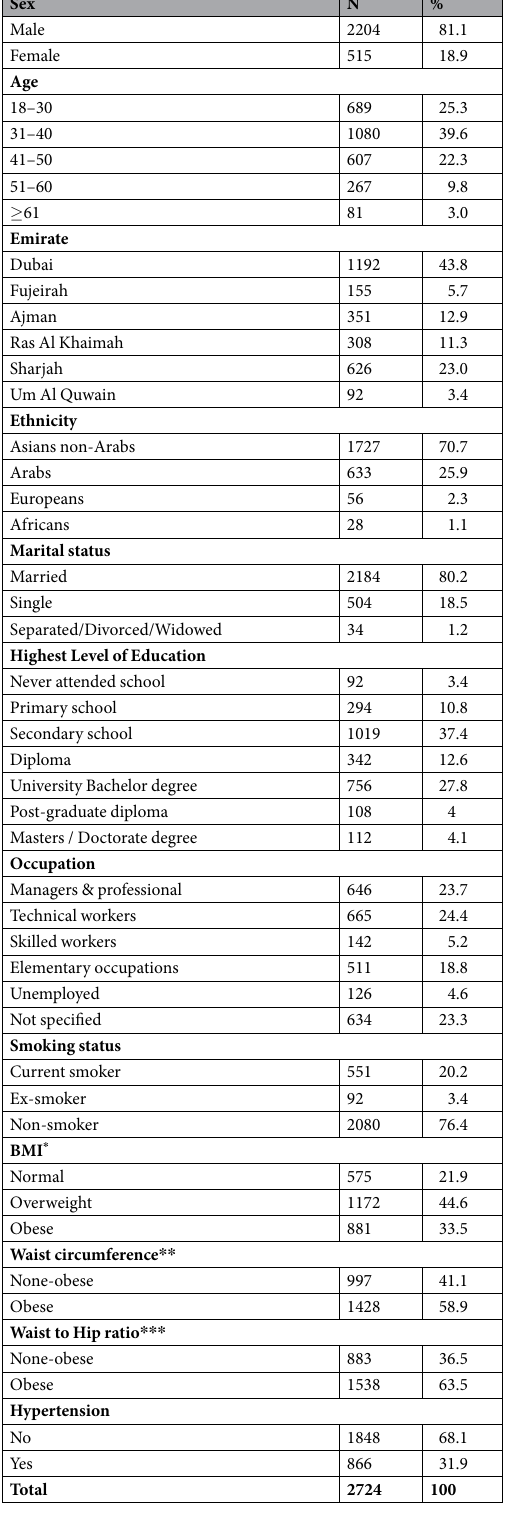
Table 1. Demographic Characteristics of Migrant Study Population. * BMI was categorized according to the following criteria (Normal: Arabs & Europeans – BMI < 25 Asians–BMI < 23; Overweight:Arabs & Europeans – 25 ≤ BMI < 30, Asians – 23 ≤ BMI < 27.5; Obese: Arabs & Europeans – BMI ≥ 30, Asians – BMI ≥ 27.5). ** Waist Circumference was categorized according to the following criteria (obese: Arabs – males WC ≥ 102 cm & females ≥ 88; Asians – males WC ≥ 90 cm & females ≥ 80; Europeans – males WC ≥ 94 cm & females ≥ 80). *** Waist to Hip ratio (WHR) was categorized according to the following criteria (WHR for males ≥ 0.90 cm & females ≥ 85 indicated Obesity for all